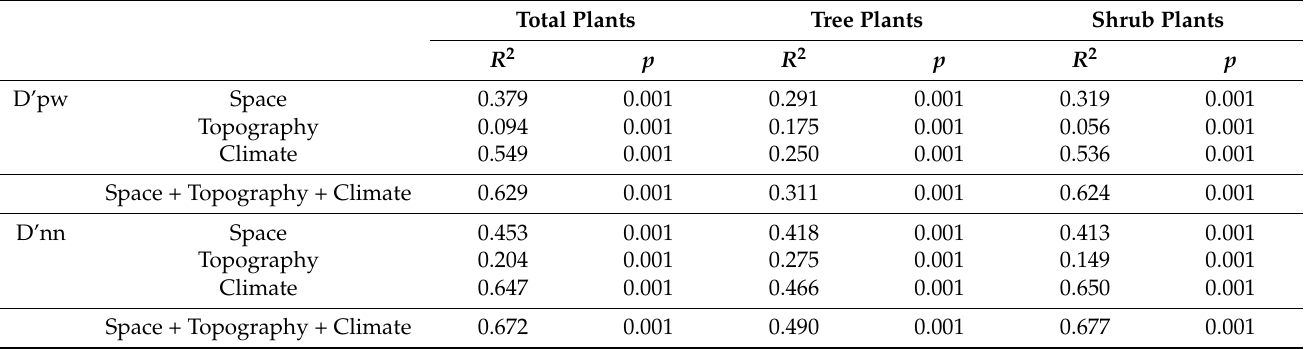
Table 3. Variation in phylogenetic β -diversity was analyzed in relation to spatial, climatic, and topo- graphic factors for total plants, trees, and shrubs using the multiple regression on distance matrix (MRM) test.